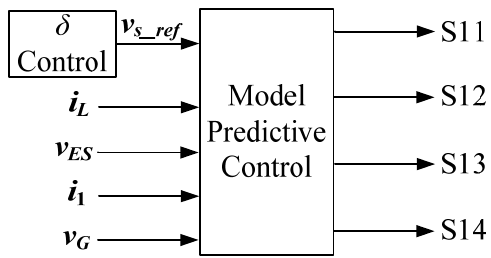
Figure 3. The proposed MPC based on δ control.